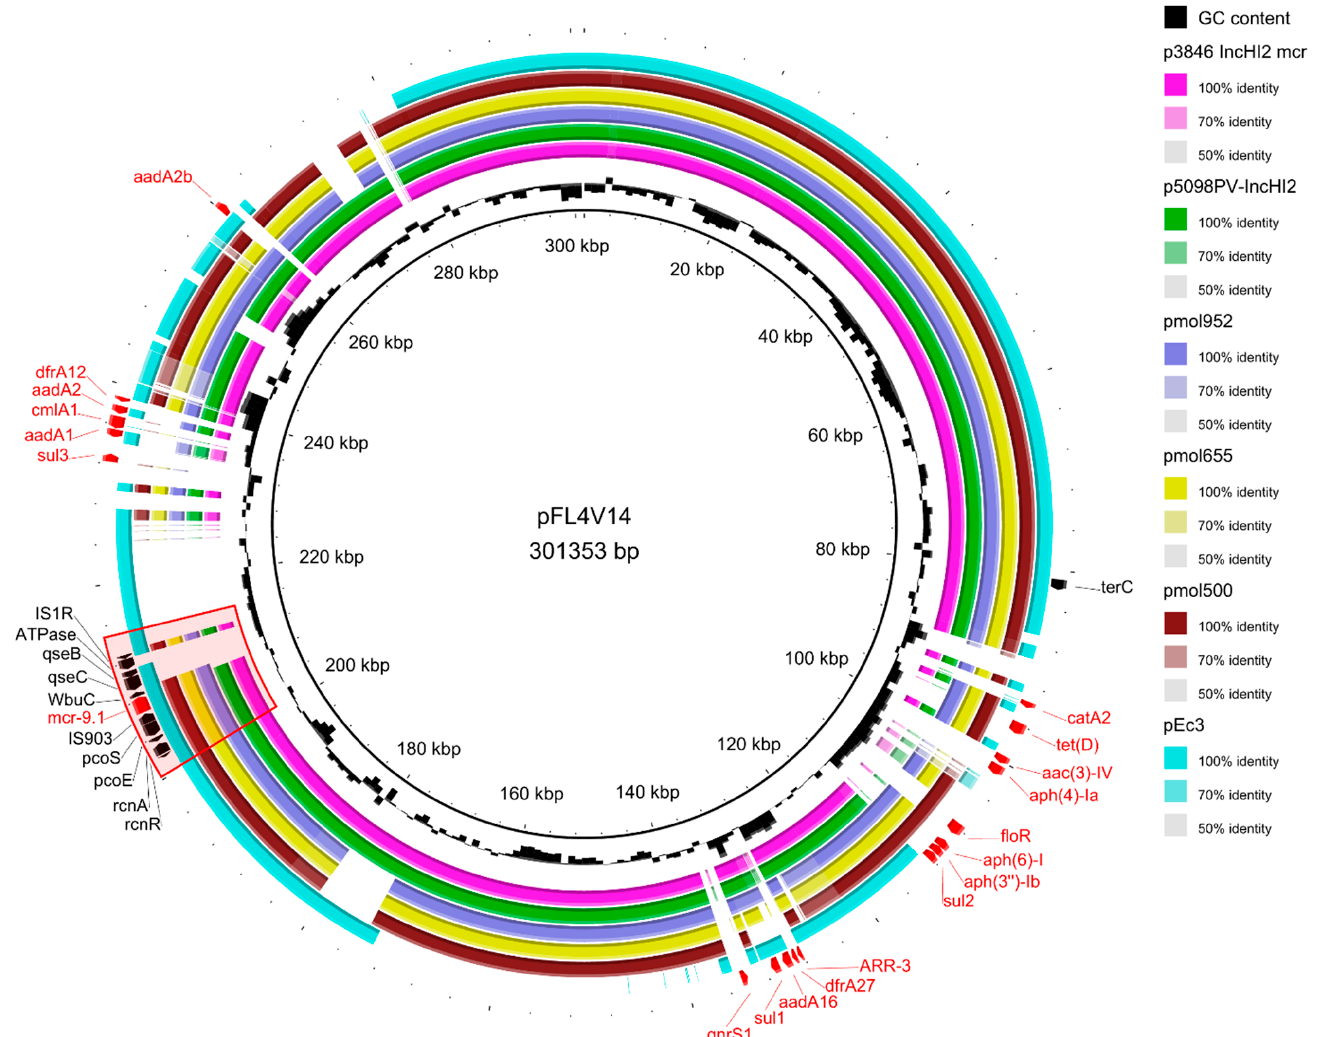
Figure 2. Circular map of IncHI2 plasmid pFL4V14 isolated from E.coli_MDRbs22 compared to other mcr-9-carrying plasmids found in Italy [24–27]. Resistance genes and the mcr-9 cassette have been highlighted in red. Table 1. Resistance genes detected by WGS in E.coli_MDRbs22 isolated from a pig, correspond- ing minimum inhibitory concentrations (MICs) and applied cut-offs for the tested antimicrobials. Resistances are highlighted in